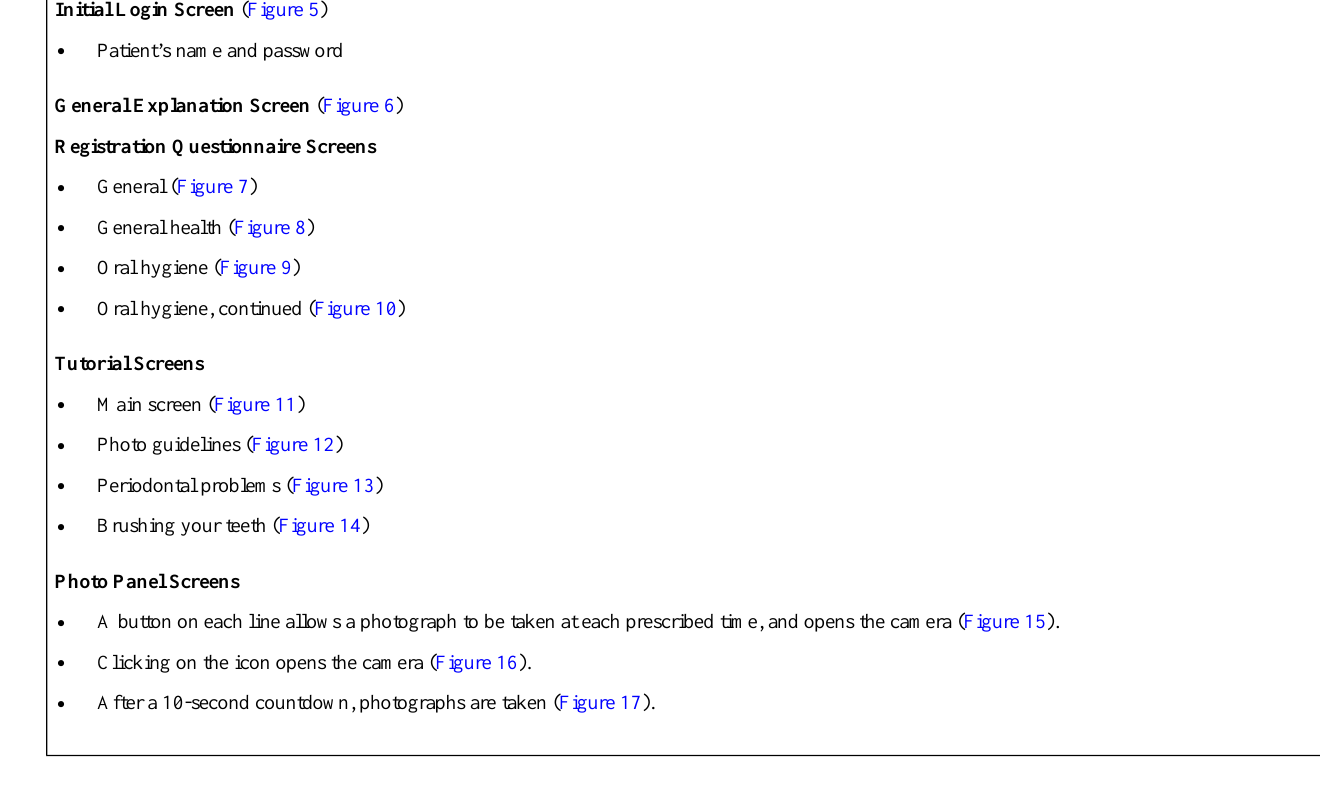
Figure 5. Initial login screen for the patient: patient name and